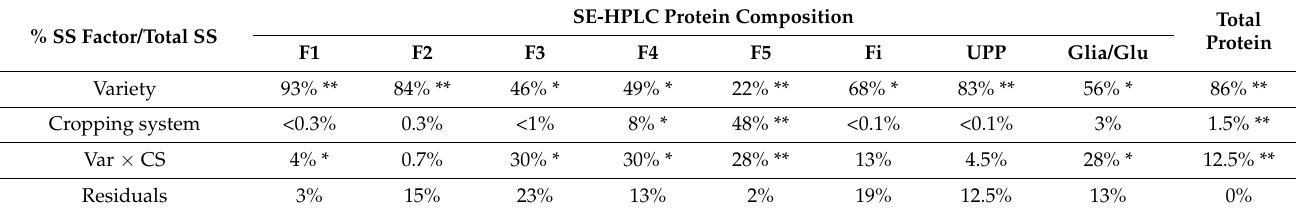
Table 8. Contribution of each factor (Sum of squares of the different factors (Variety, Cropping system)/total sum of squares) to the variability of the protein fractions in semolina (stone-milled grains). The model of analysis of variance was: Param = Variety + Cropping system + (variety × cropping system) + residuals, with Param = the protein fraction, UPP or the protein content.